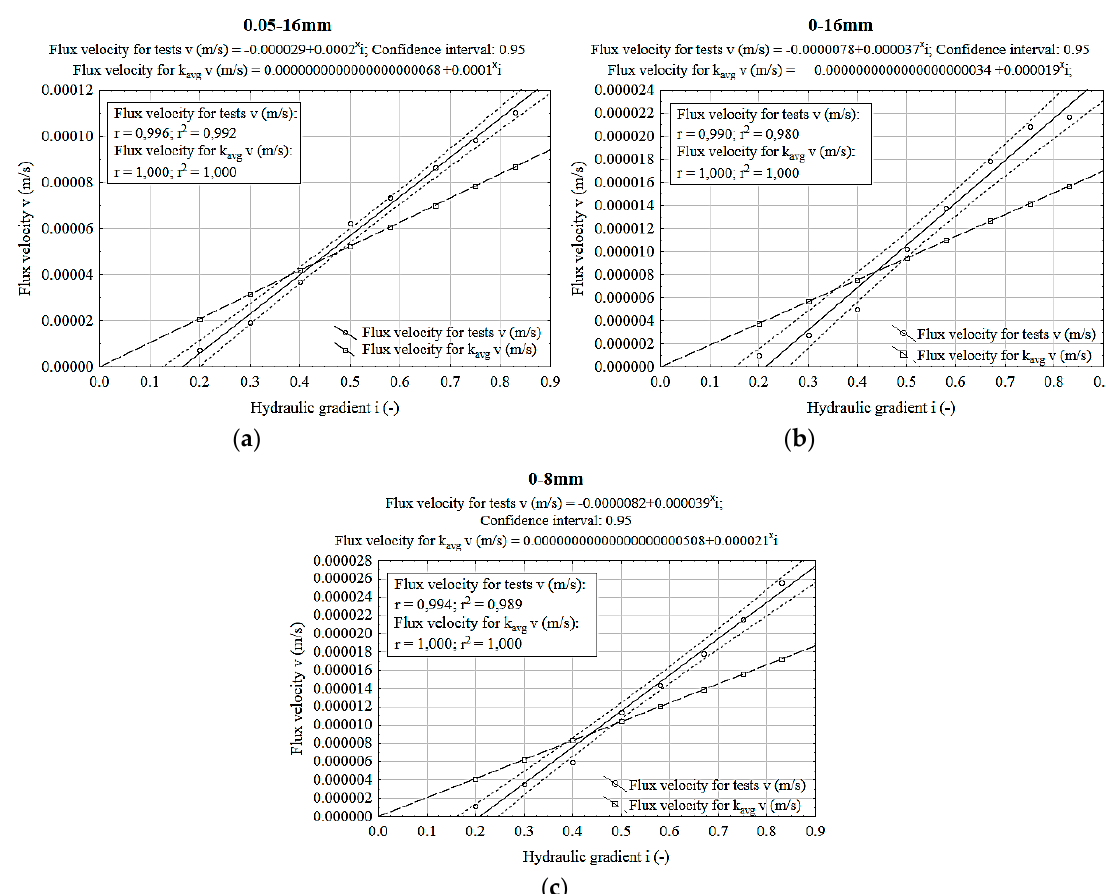
Figure 9. Prediction of the threshold gradient on the basis characteristic linear trend line for blend 0–8 mm. ( a ) blend 0.05–16 mm; ( b ) blend 0–16 mm; ( c ) blend 0–8 mm. Table 4. Summary of the calculation results for the threshold gradient calculation